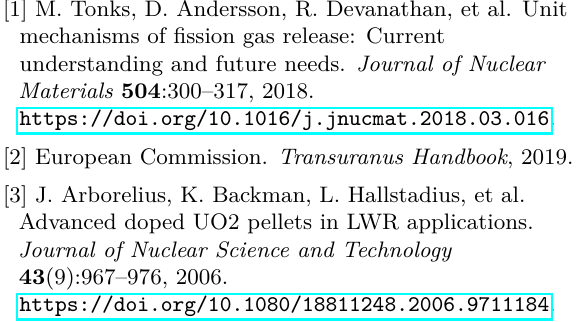
Table 5. Fission gas release comparison at the end of